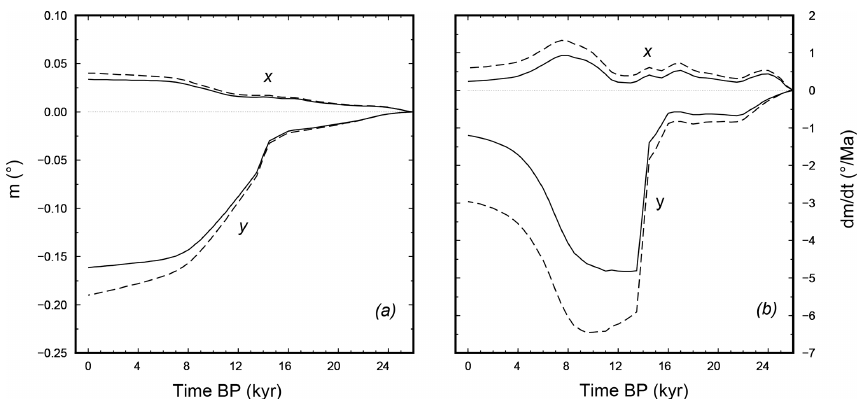
Figure 7. Cartesian components of polar motion along the axes x and y (a) and their time derivatives (b) as a function of time since the beginning of deglaciation for the test run with configuration R44/L128/I3 . The x axis points along the prime meridian and the y points to 90 ◦ E. Dashed and solid curves show results for the traditional and for the revised rotational theories, respectively. The steep change in the y components at ∼ 14ka is forced by the inertia variations due to the occurrence of the meltwater pulse 1A